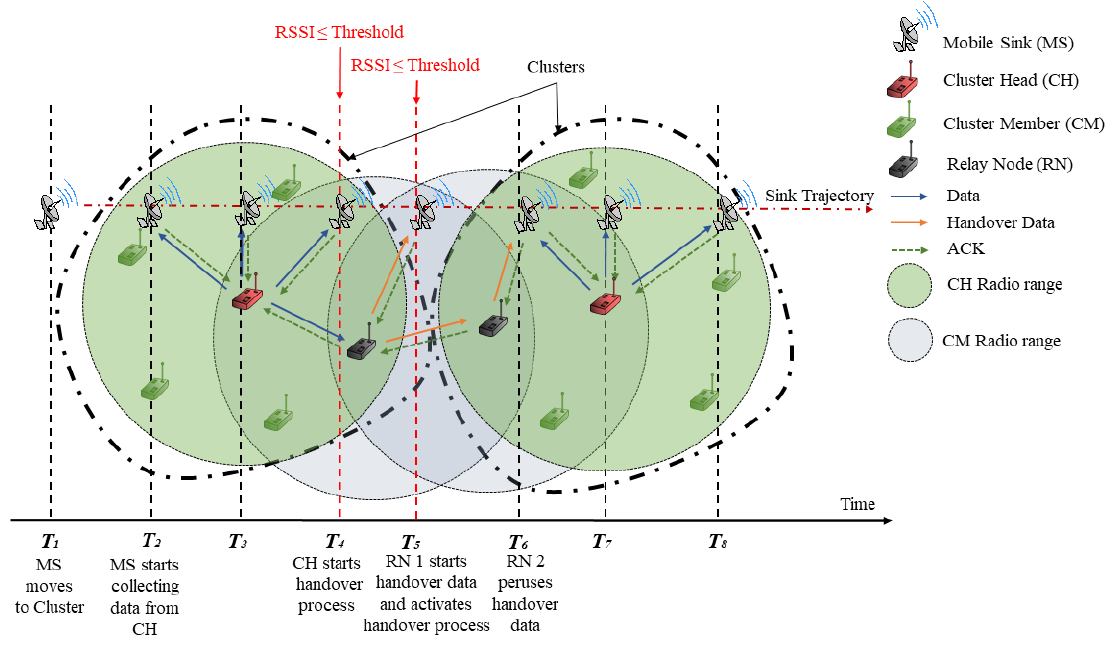
Figure 1. Proposed Handover Mechanism CLR-MSPH in Cluster-Based Wireless Sensor Network.